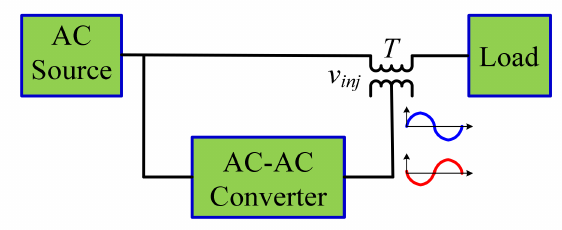
Figure 4. A direct approach of voltage